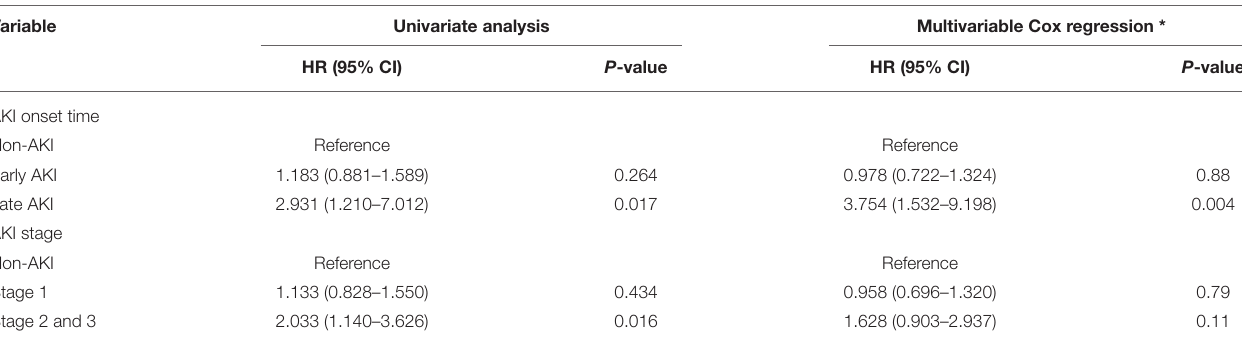
TABLE 4 | Association between onset time and stage of acute kidney injury and 3-year mortality.